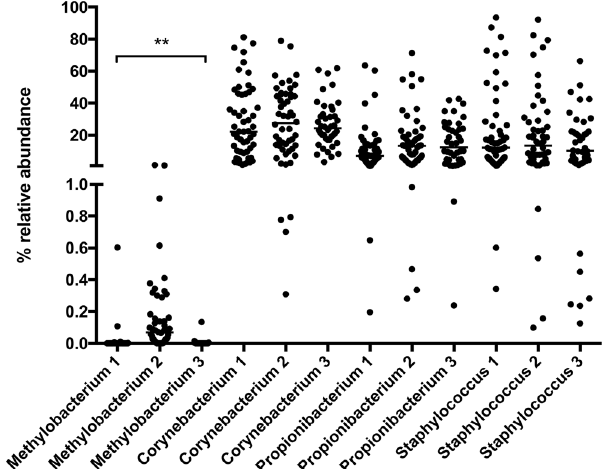
Figure 6. Relative abundance of selected genera in anterior nasal microbial communities according to swab type. Shown are those genera that either were the most abundant or showed a statistically different abundance across swab types (indicated as 1, 2 and 3, respectively; see Methods for details about the swabs). ** p < 0.01 (Kruskall-Wallis test with post-test Dunn’s). The horizontal lines indicate median values.